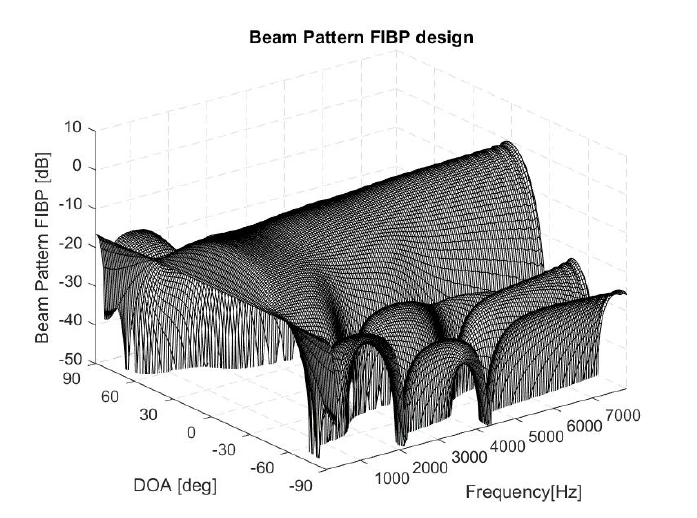
Figure 6. Beam pattern RLSFIB design.